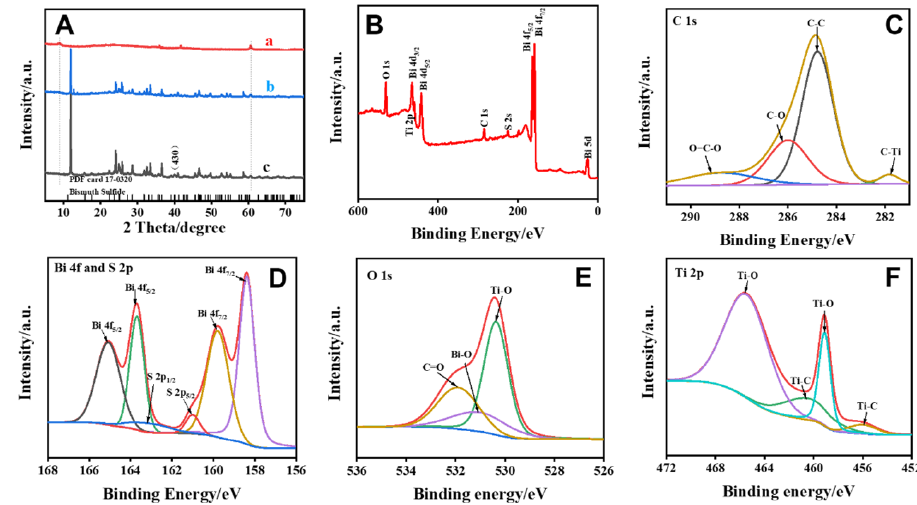
Figure 2. ( A ) XRD patterns of (a) Ti 3 C 2 T X MXene, (b) Bi 2 S 3 /Ti 3 C 2 T X MXene nanosheet and (c) Bi 2 S 3 ; ( B ) XPS survey spectra analysis of Bi 2 S 3 /Ti 3 C 2 T X MXene; High-resolution XPS spectra of ( C ) C 1s; ( D ) Bi 4f; ( E ) O 1s and ( F ) Ti 2p.